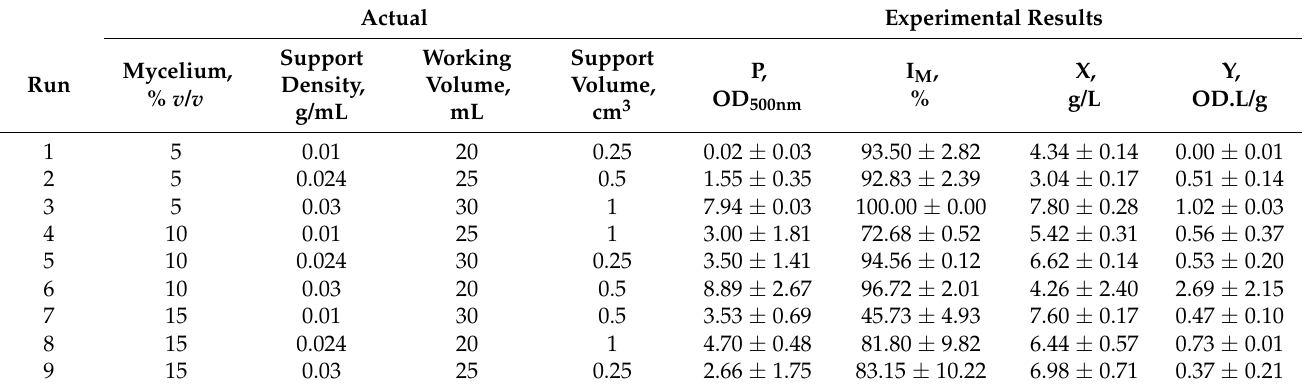
Table 2. Experimental design and results of L9 array for immobilization process improvement. Actual Experimental